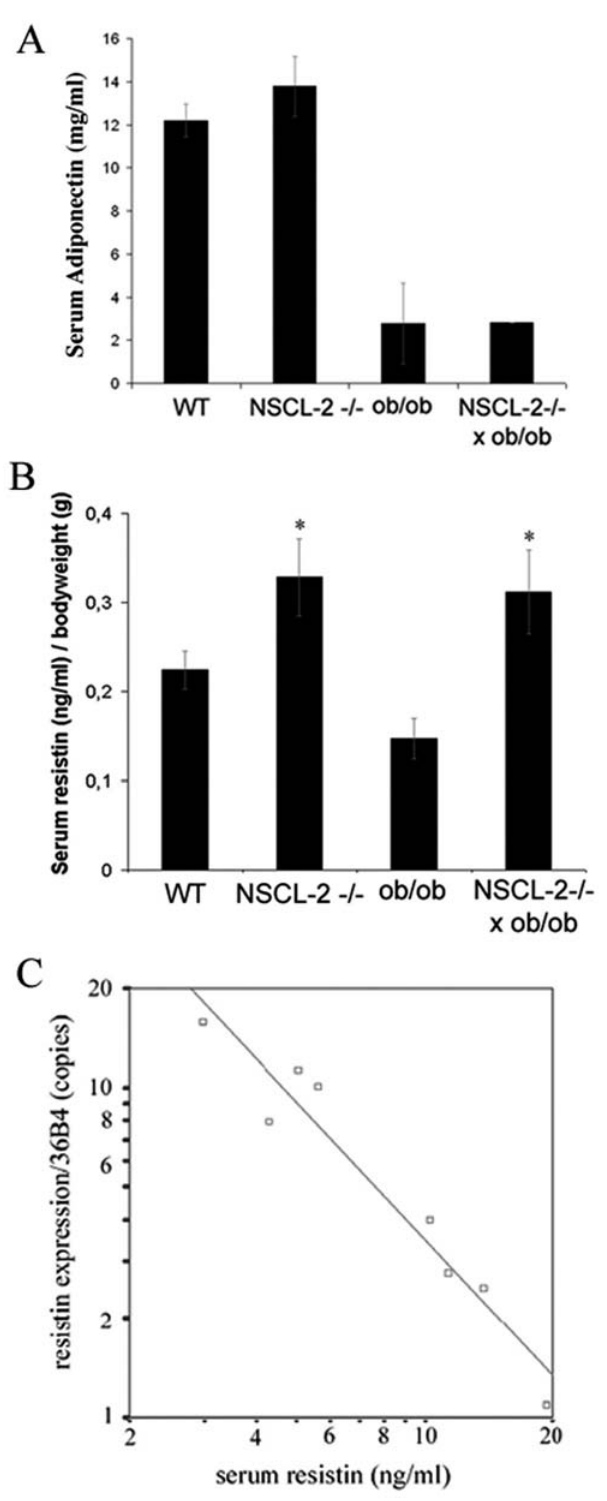
Figure 4. Nscl-2 mutant mice show increased serum adiponec- tin and resistin levels. (A) High serum adiponectin levels in adipose Nscl-2 mutant mice. Adiponectin levels in 6–8 months old WT control (n=4), Nscl-2 ( 2 / 2 ) (n=9), ob/ob (n=3), and Nscl-2 ( 2 / 2 ) 6 ob/ob (n=1). (B) Increased serum resistin levels in Nscl-2 and Nscl-2/leptin compound mutant mice. Serum resistin level were divided by body weights of WT (n=23), Nscl-2 ( 2 / 2 ) (n=15), ob/ob (n=14) and